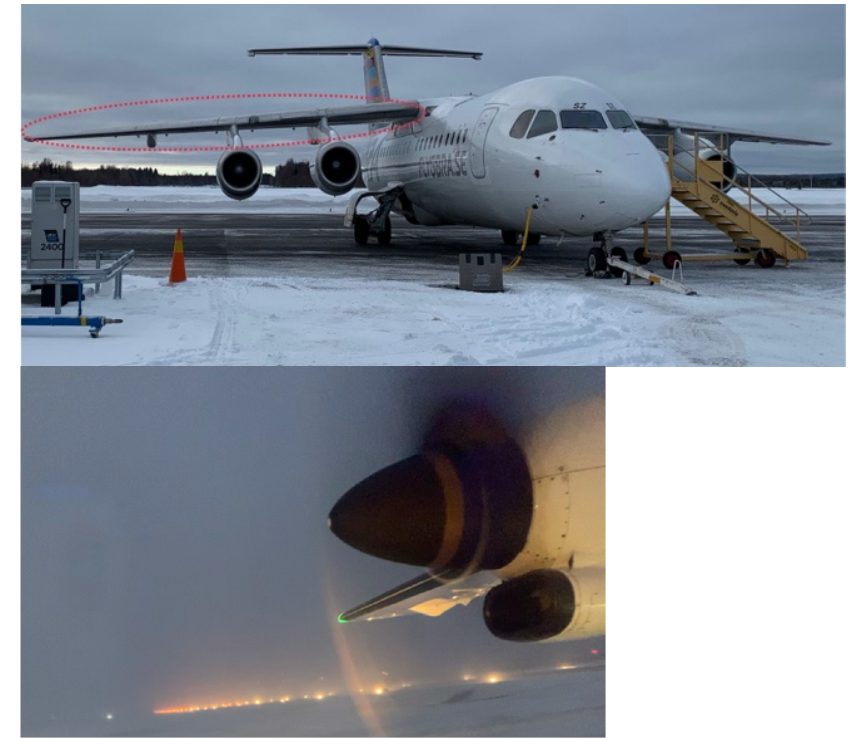
Figure 9. Examples of pneumatic deicing boot.